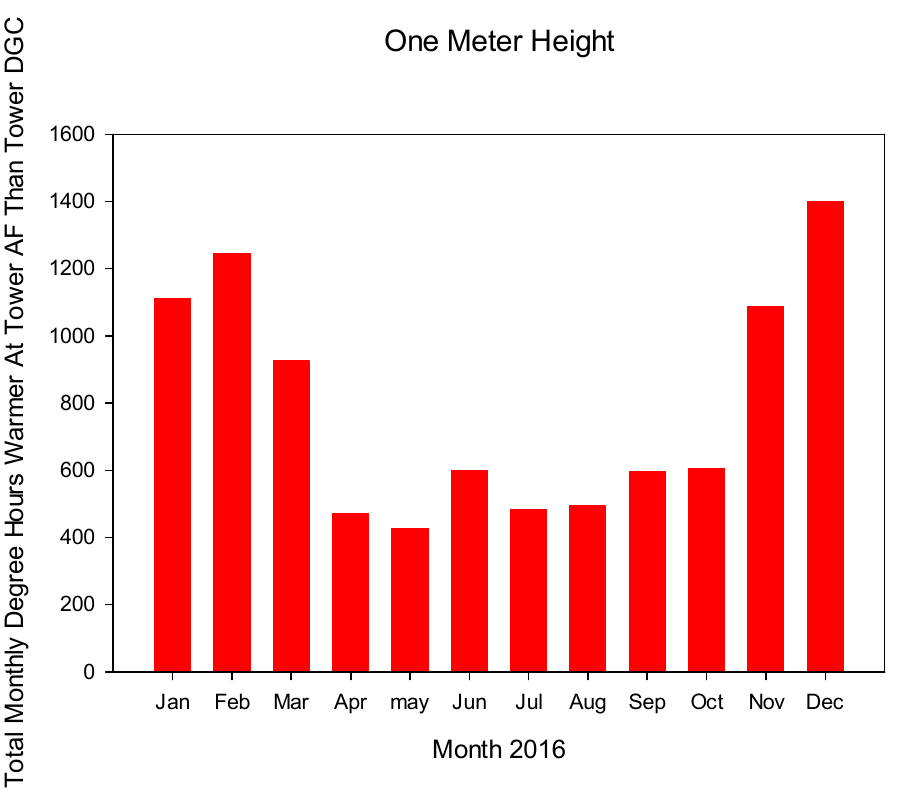
Figure 9. Total monthly degree hours warmer at tower AF than tower DGC in 2016.